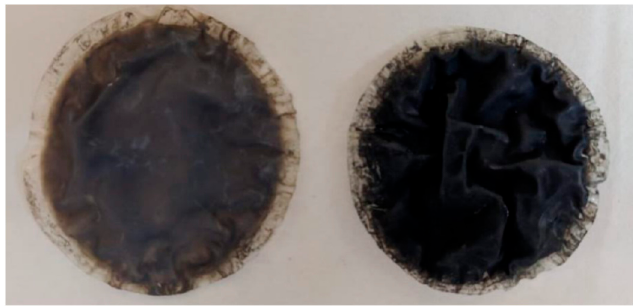
/ TiO Figure 8. 2% rGO/TiO 2 membrane before (left) and after 96 h of use (right). Figure 8. 2% rGO 2 membrane before ( left ) and after 96 h of use ( right